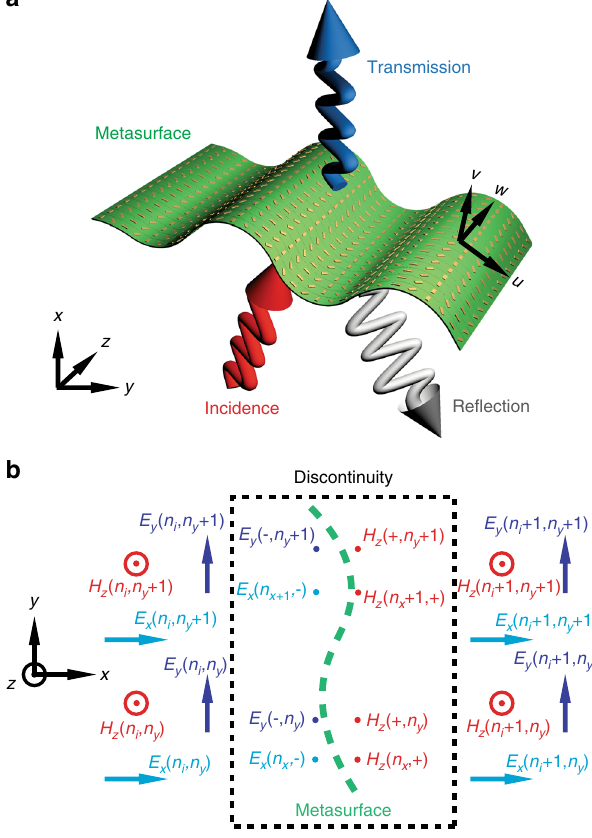
Fig. 1 Schematic of the structure and the implementation of conformal boundary condition using FDTD algorithm. a Schematic of conformal metasurfaces of arbitrary geometries to modulate light propagation. b For non-planar geometry, conformal boundary conditions, given by Supplementary Eqs. (5) and (6) are implemented by inserting virtual nodes around to the normal Yee cell. The modi fi cation includes introducing virtual magnetic nodes H n (cid:2) 1 = 2